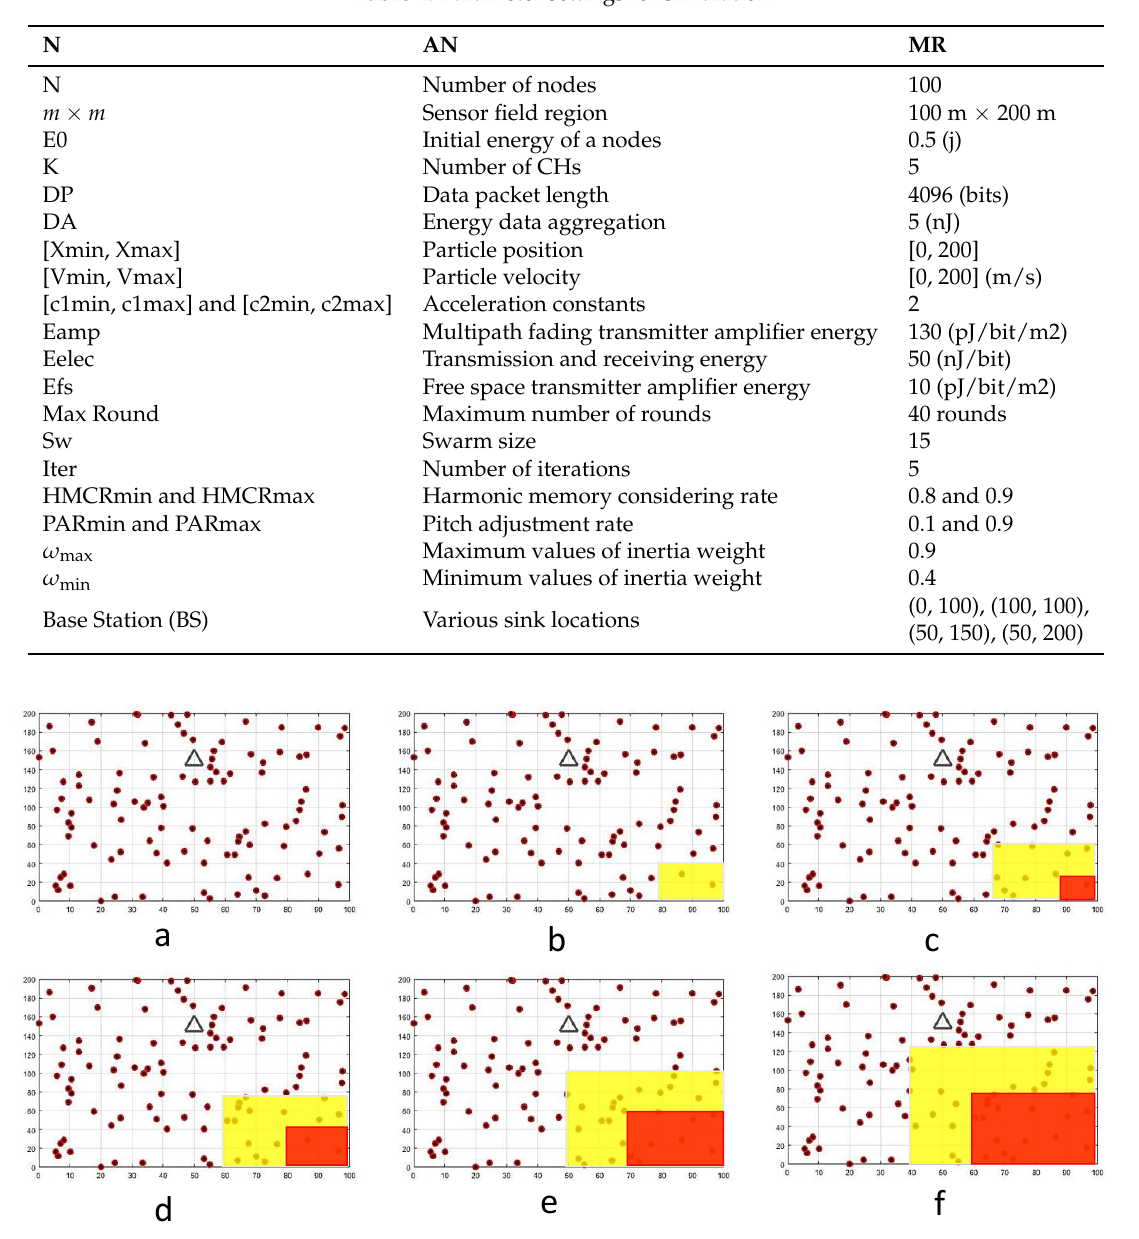
Figure 7. Simulation scenarios for forest fire in this work: ( a ) The normal state of the environment; ( b ) Fire smoke changes the state of the environment; ( c ) The fire starts in the forest; ( d – f )— illustrates the spread of fire until 40 round of